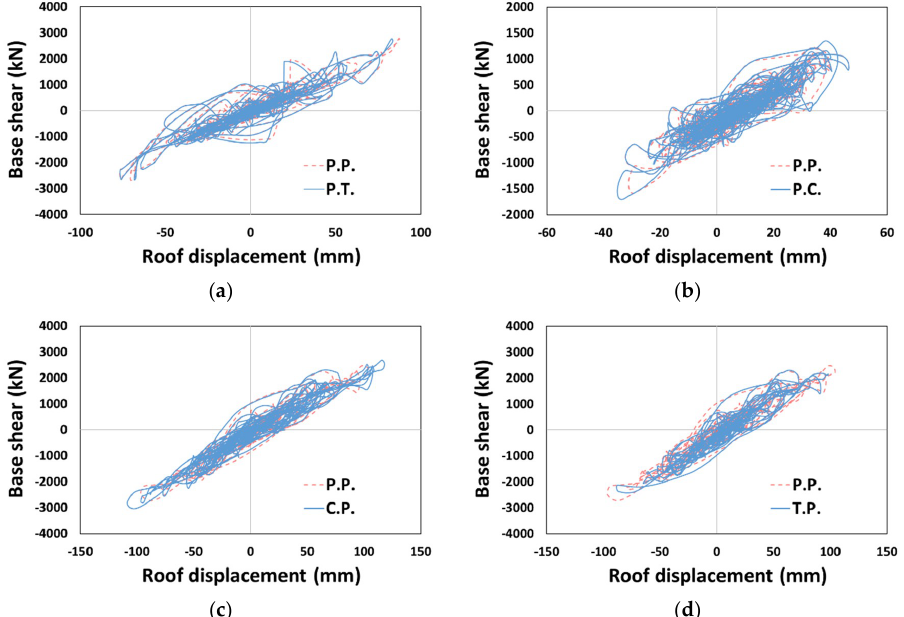
Figure 6. Base shear–displacement curves: ( a ) P.T. (Type 1, El Centro, X-dir.), ( b ) P.C. (Type 2, El Centro, Y-dir.), ( c ) C.P. (Type 3, El Centro, Y-dir.), and ( d ) T.P. (Type 3, El Centro, Y-dir.). The cumulative dissipated energy over time for each type of El Centro ground mo-